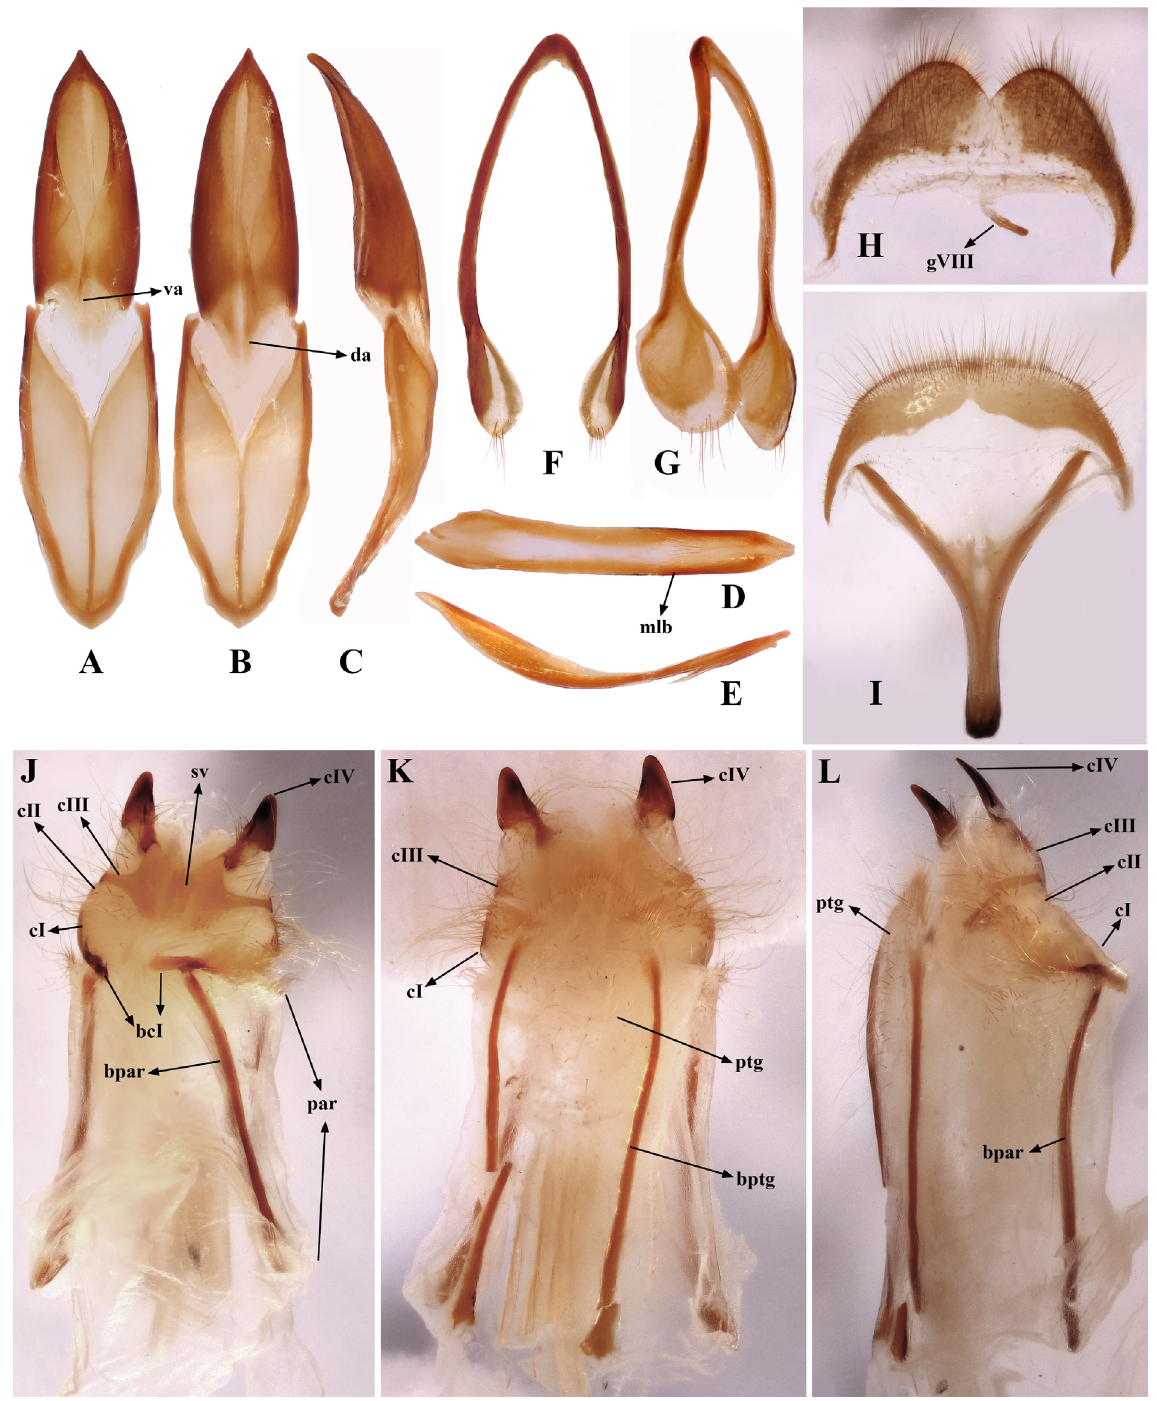
Fig. 20. Platyope leucogramma (Pallas, 1773) , genitalia (ZIN). A . Tegmen of aedeagus,